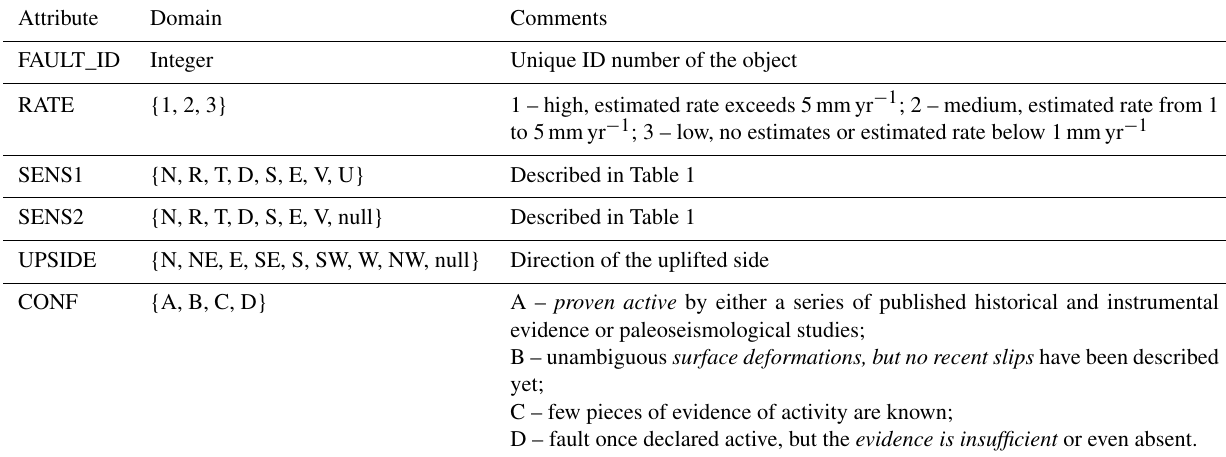
Table 2. Values of derivative